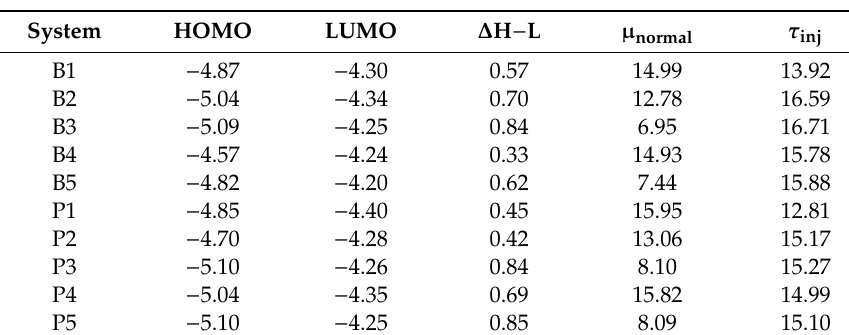
Table4. Calculatedenergylevelparameters(ineV),verticaldipolemomentoftheisolateddyesabsorbed on (TiO 2 ) 38 clusters (in Debye), and electron injection time (in fs) for the studied dye / (TiO 2 ) 38 systems.